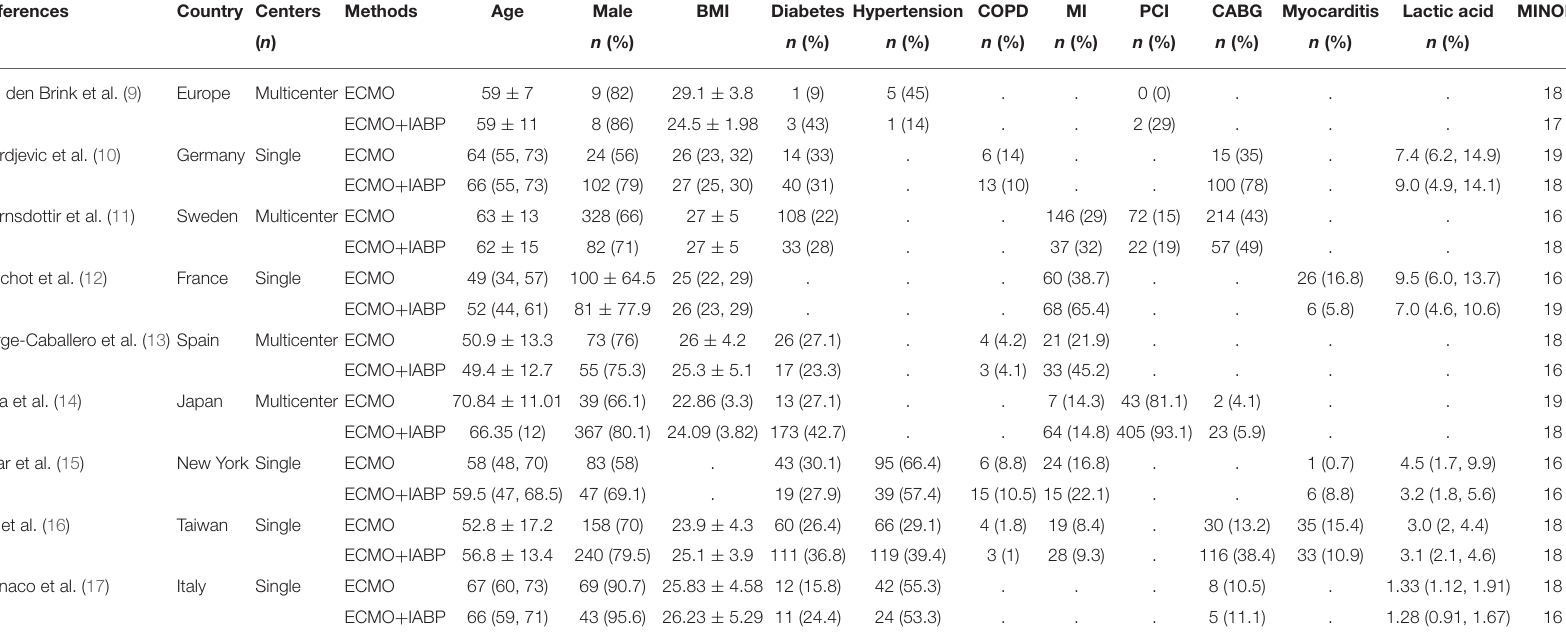
TABLE 1 | Characteristics of the included